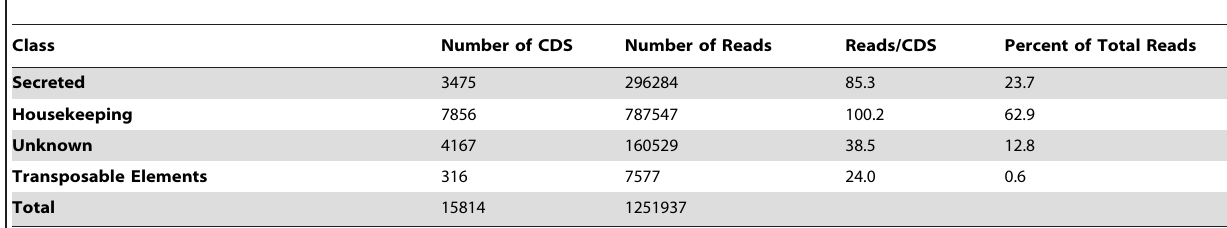
Table 1. Nature and abundance of reads for extracted coding sequences (CDS) from the sialotranscriptome of Amblyomma maculatum